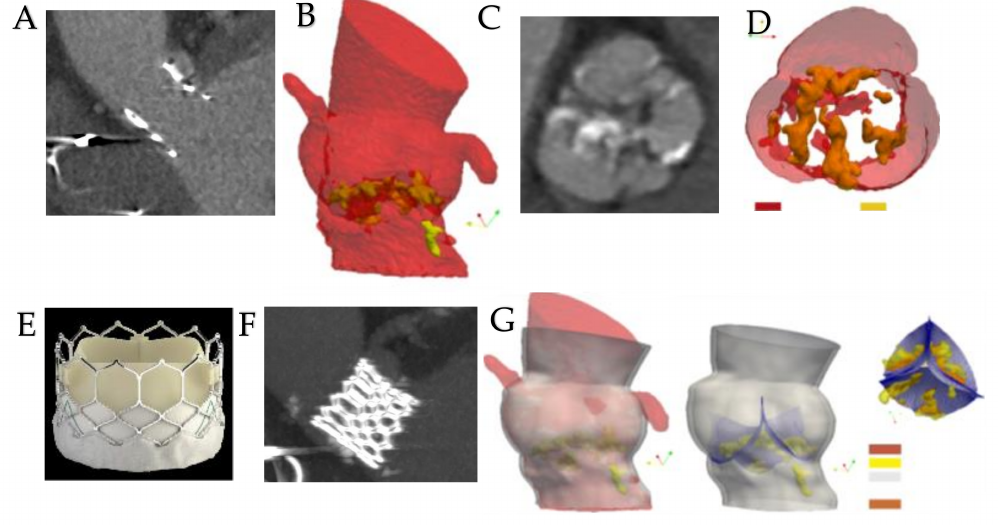
Figure 5. Up : With the use of ITK-Snapv 2.4 the data extracted from the CT images, ( A , C ) are pro- cessed to highlight the images of the aortic lumen ( B , red) and calcium deposits ( D , yellow/orange). Down : A first generation of balloon-expandable TAVI Sapien ( E ; Edwards Lifesciences, Irvine, CA, USA) is used to treat severe AVS ( F ). G : Aortic lumen morphology as well as the calcium con- glomerates are extracted with the use of STL files. Left : The lumen of the aortic root (red) and the calcifications (yellow) are superimposed to the aortic wall model (gray). Center : The enclosed native leaflets (blue mesh) correspond perfectly to the real leaflets with calcifications obtained by processing CT images ( A , C ). Right : The top view is shown. Abbreviations: AVS, aortic valve stenosis; CT, computed tomography; STL, stereolithographic; TAVI, transcatheter aortic valve